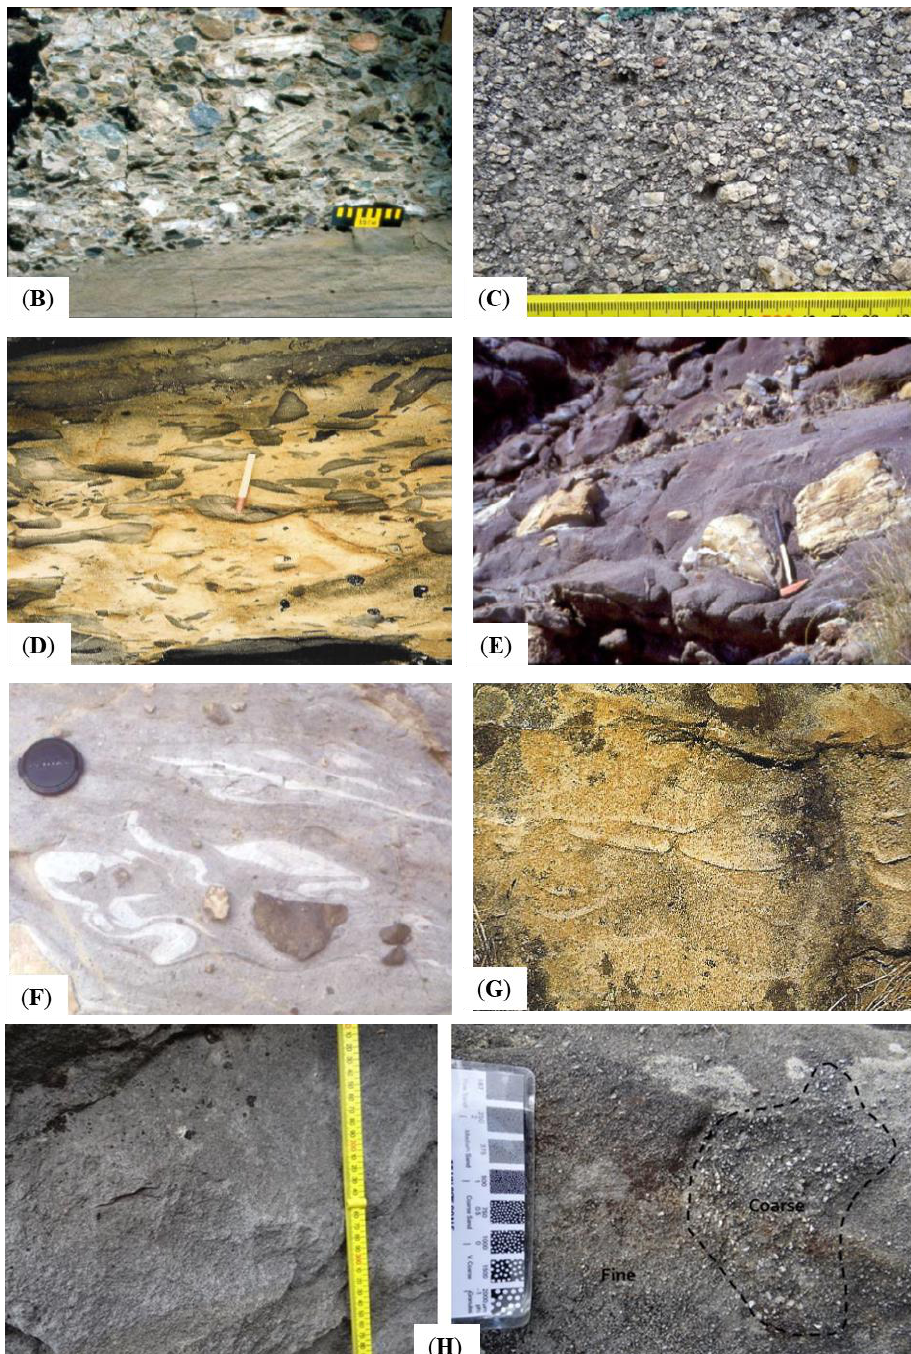
Figure 7. Coarse-grained turbidite / debrite family: photographic examples. ( A ) Very thick-bedded structureless sandstone turbidite succession (deep-water massive sands), Carpathian Flysch, Romania. ( B ) Clast-supported conglomerate turbidite with clast-alignment and erosive, reverse-graded base, Dana Point, California. ( C ) Shale-clast-rich sandstone, turbidite-debrite transition, Carmelo, California. ( D ) Sandy, matrix-supportedconglomerate(toboulder-richsandstone)non-cohesivedebrite, TabernasBasin, SE Spain. ( E ) Matrix-supported cohesive debrite, near Benidorm, SE Spain. ( F ) Deep-water massive sandstone turbidite with water-escape dish-structures, Cantua Basin, California. ( G ) Deep-water massive sandstone turbidite, structureless, Peira Cava, SE France. ( H ) Deep-water massive sandstone turbidite, structureless, with patchy grain-size variation, Peira Cava, SE